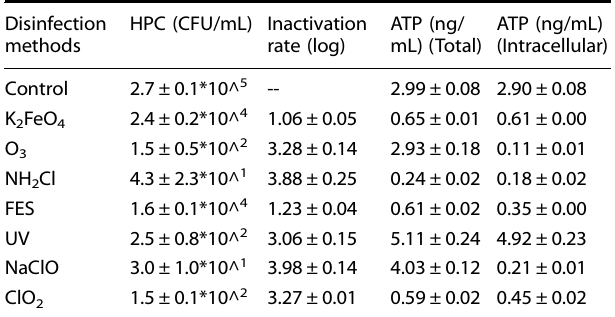
Fig. 1 Fouling degree of RO membranes with DRB bio fi lm (32 days) after seven different kinds of disinfection treatment. a The normalised fl ux of fouled membranes and b the hydraulic resistance of the bio fi lms. The experiment was conducted in parallel in three sets. Error bars represent the standard deviation for three independent experiments. The p value was generated by t test (* p < 0.05, ** p < 0.01). Table 1. Disinfection effect measured by HPC and ATP